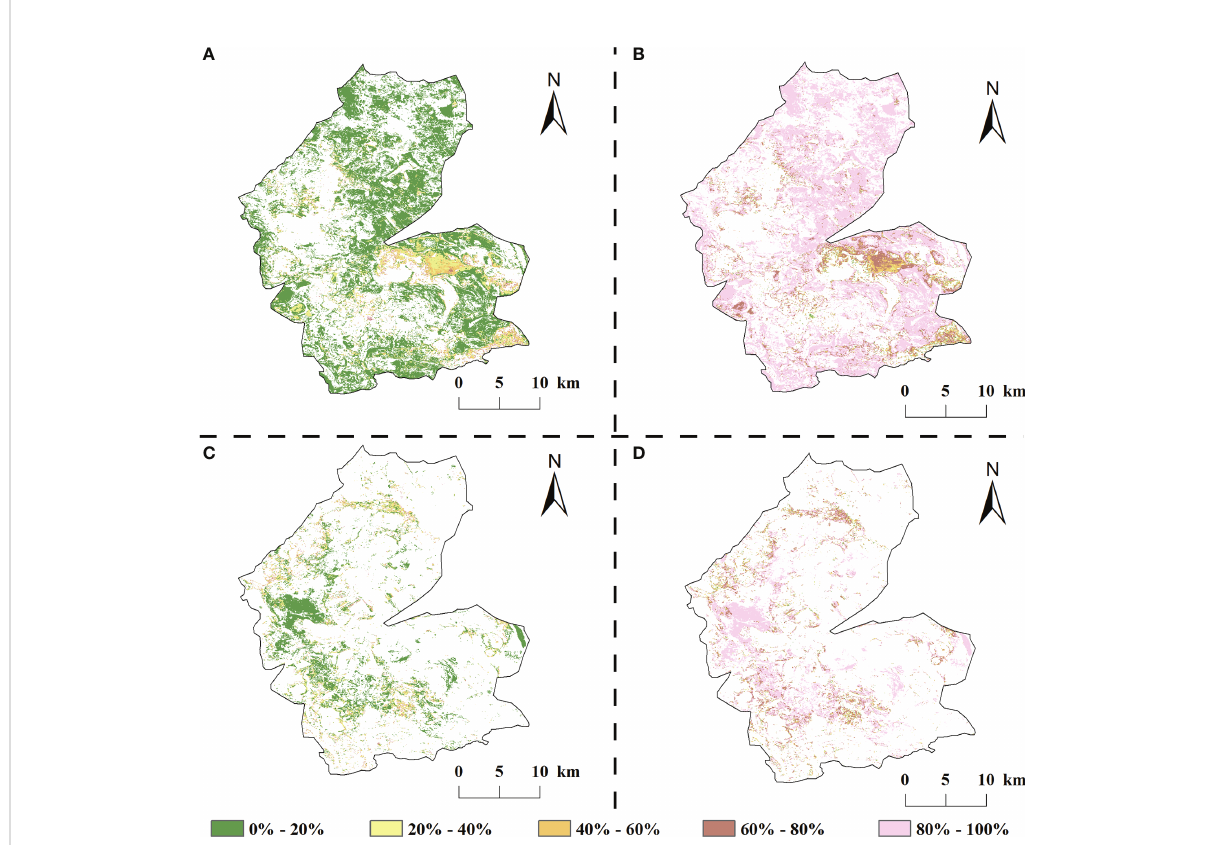
FIGURE 10 Relative contribution of climate change and human activities study areas, 1984-2020 ( A , B are the relative contribution of climate change, human activities to vegetation improvement areas, respectively; C , D are the relative contribution of climate change, human activities to vegetation degradation areas,